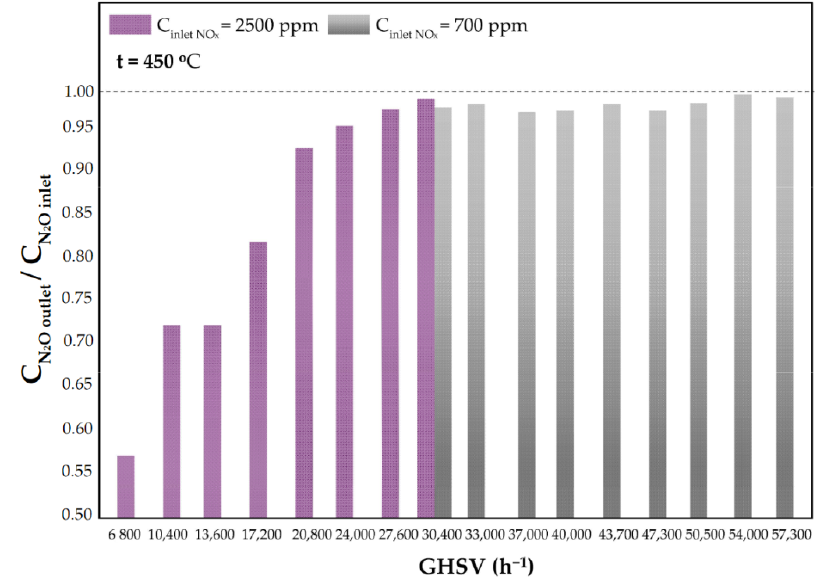
Figure 11. The ratio of the N 2 O concentration at the reactor outlet to the inlet N 2 O concentration as a function of GHSV for the Fe-Clin-I shaped catalyst sample at 450°C and C inlet (NO x ) = 2500 ppm and C inlet (NO x ) = 700 ppm.